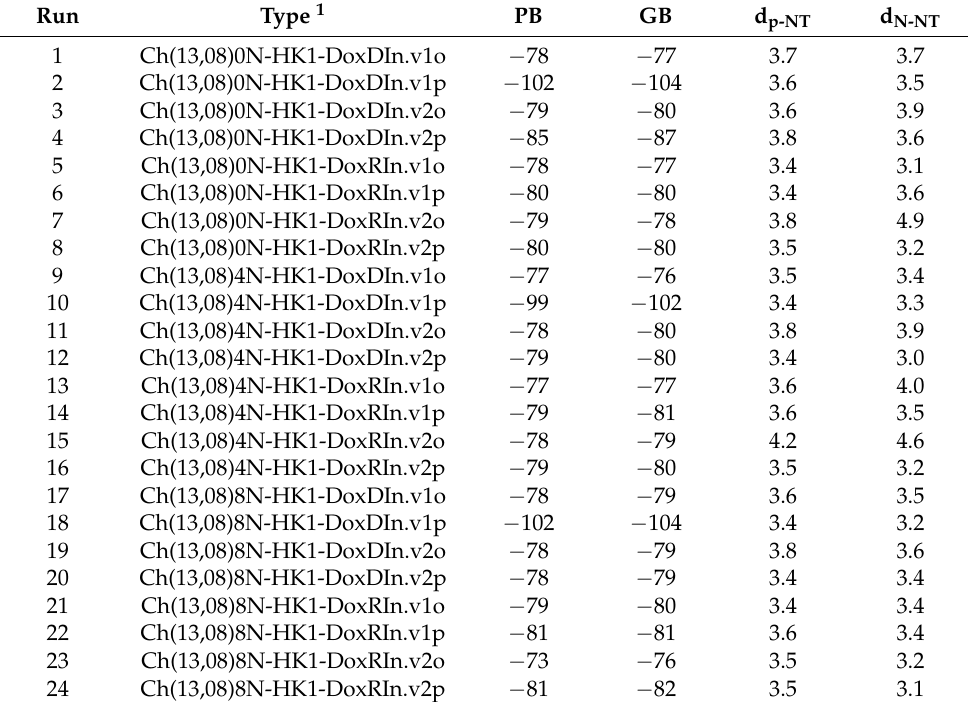
Table 1. DOX-CNT Poisson–Boltzman (PB) and generalized bond (GB) binding energies (in kcal/mol) for the nitrogen doped and undoped chiral nanotubes (34 Å length) having one haeckelite defect, Hk1, considering encapsulated system. d p-NT are the distances from the DOX anthraquinonic plane to the nanotube wall; d N-NT is the distance from the DOX nitrogen atom to the nanotube wall. All distances are expressed in